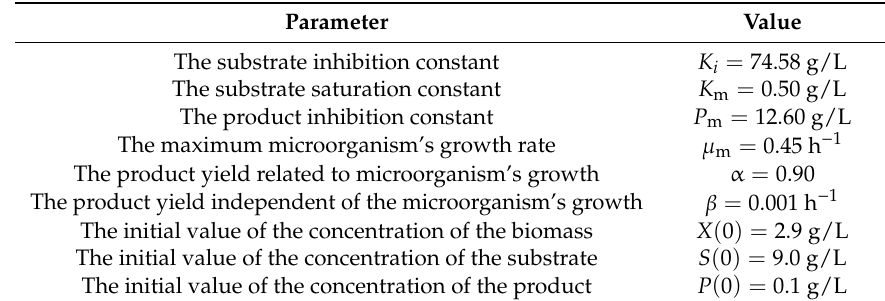
Table 1. Parameters and initial values of the non-linear (autonomous) mathematical model of the analysed fermentation process in the batch bioreactor [31].